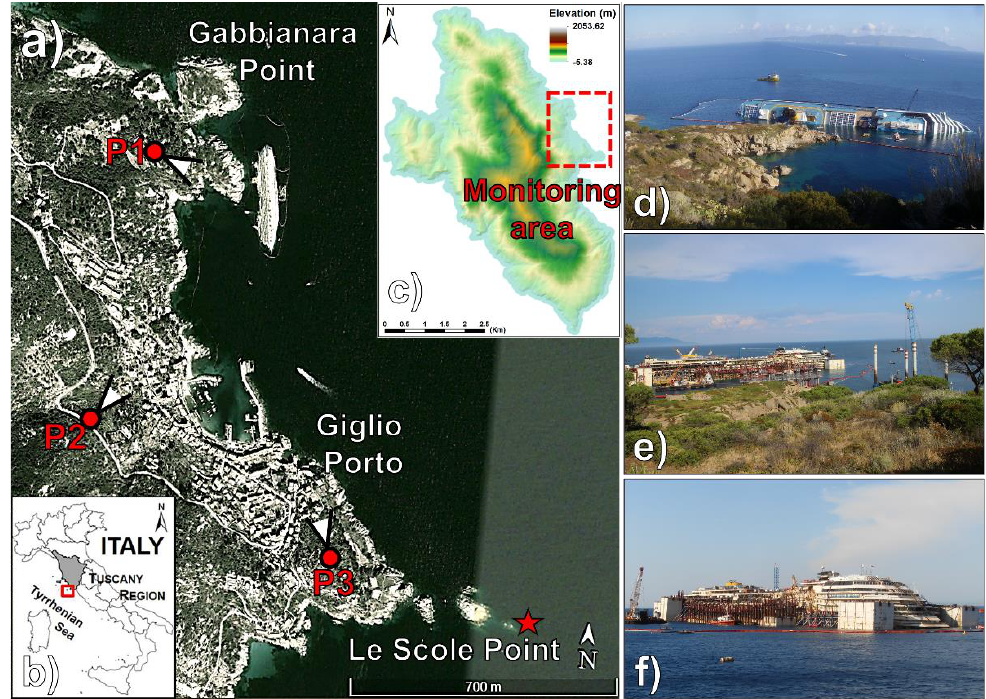
Figure 1. Setting of the study area: ( a ) location of the Costa Concordia after the wreck on Google Earth TM satellite image (March 2012) showing the IRT survey points (P1 = Lazzeretto Point; P2 = Giglio Castello road; P3 = Cannelle); ( b ) geographic setting of the Giglio island (Tuscany/Central Italy); ( c ) elevation map of Giglio Island (red dashed square shows the monitoring area). Pictures of the Costa Concordia shipwreck: ( d ) soon after the wreck in January 2012; ( e ) during the parbuckling operations in September 2013; ( f ) in the hull-removal phase (July 2013).